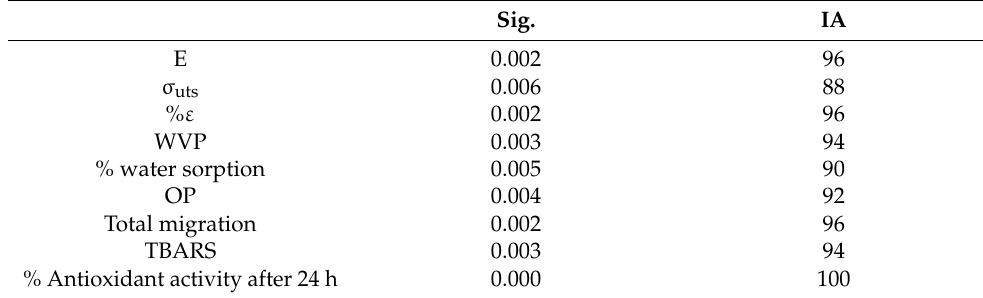
Table 3. Mean values inequality test of modulus of elasticity (E), tensile strength ( σ uts ), % elongation